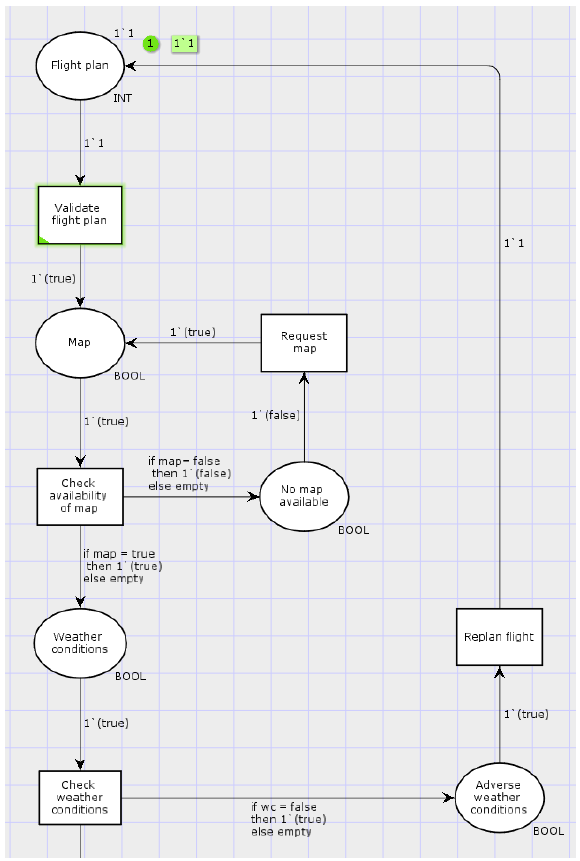
Figure 5. Top part of mission planning